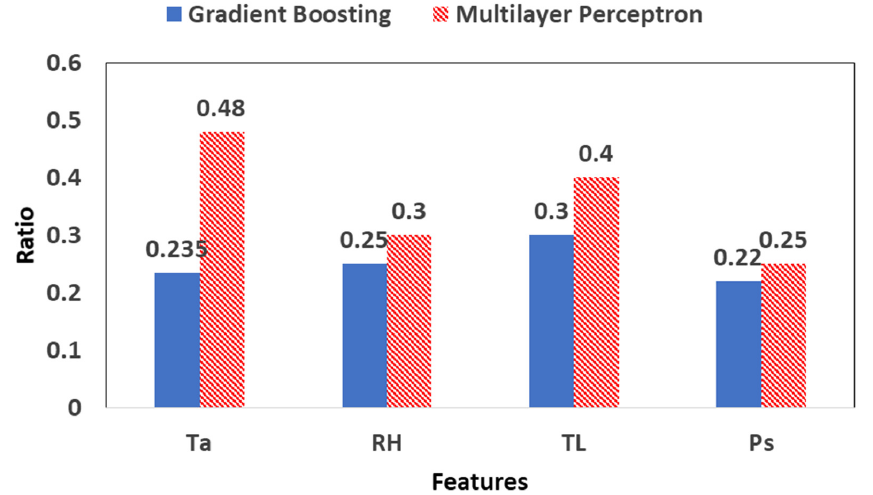
Figure 9. Feature importance of the measured factors in the set-up of GB and MLP algorithm during RUN 2.